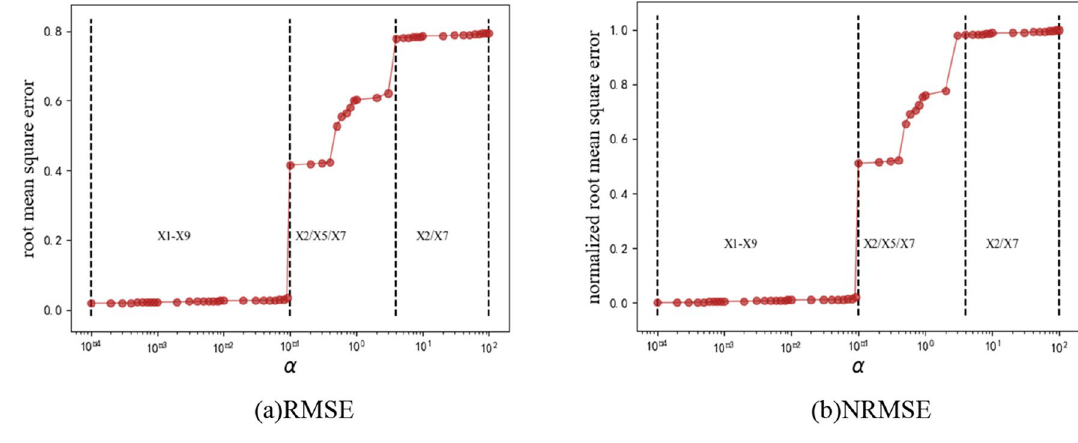
Figure 7. Variable